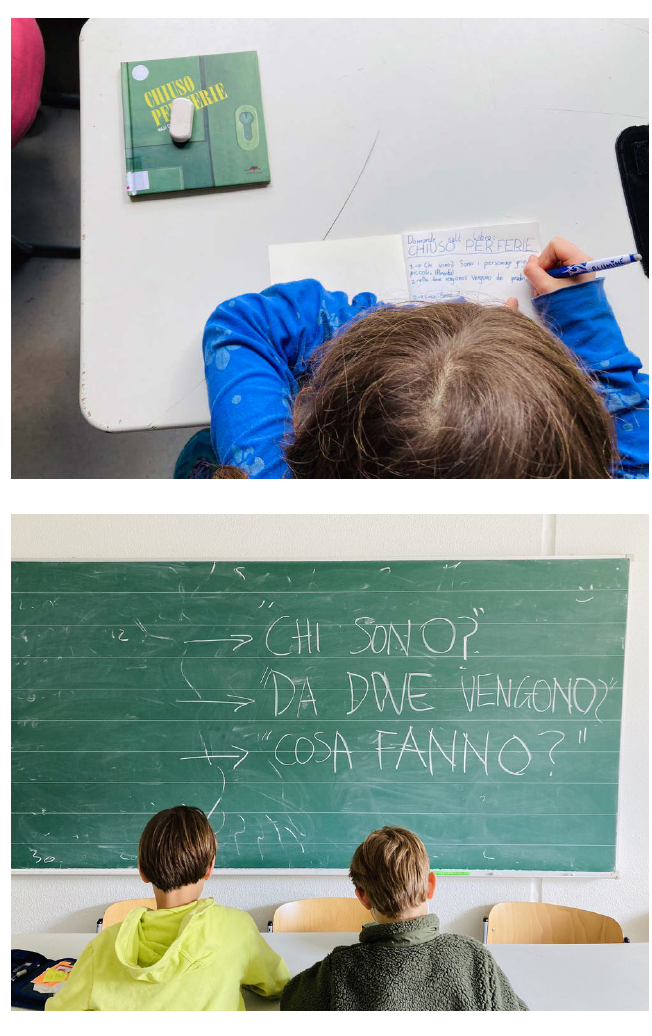
Fig. 5 Photo by Giulia Mirandola.